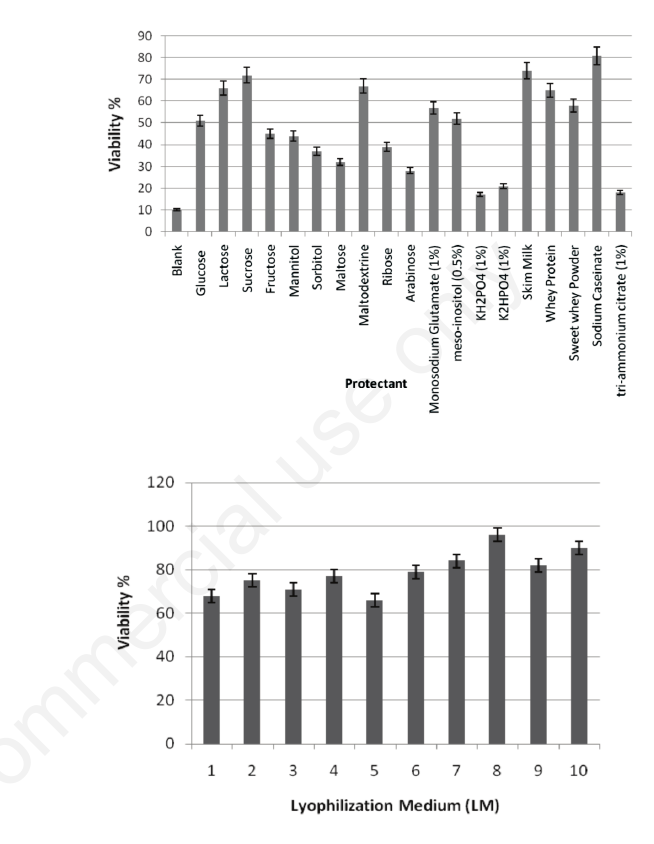
Figure 1. A) Effect of different lyoprotectants (A) and different lyophilization media (B) on the viability after lyophilization. If not indicated 10% (w/w) solution were used. The error bars show the standard deviation Table 1. Combinations of protectants along with the ratio of addition. Lyophilization medium Constituents in